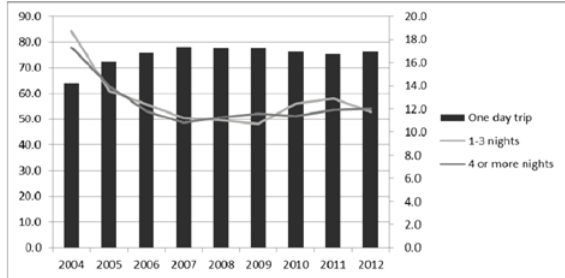
fig. 10. Share of tourists by how long they stayed in Budapest (Data Source: WizzAir, 2013)